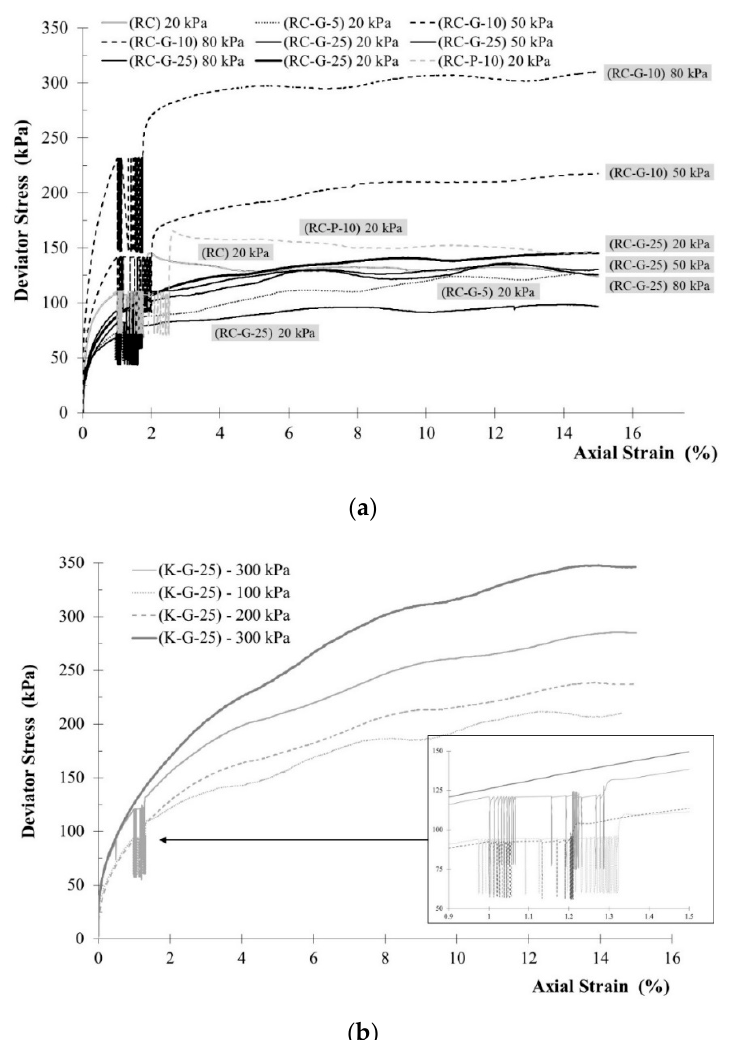
Figure 9. Deviator stress q versus axial strain ε 1 for: ( a ) (RC-R) mixtures; ( b ) (K-R) mixtures. Strengthening was observed only for monotonic tests under σ ’ 3 = 300 kPa for kaolin mixtures containing 25% granulate (K-G-25) as compared to pure kaolin ( Δ q max = +65%; Figures 9b and 10. The same mixture (K-G-25-300 kPa) weakened by 18% under cyclic loading. For red clay–rubber (RC-R) mixtures, the lack of strengthening was most likely related to specimen preparation, which was compacted in a Proctor apparatus at the op- timum moisture content. Mixtures prepared in this way may come loose after compaction relative to pure soil due to the energy-absorbing capacity of rubber [32,39,40,82]. Moreo- ver, the addition of rubber waste to the cohesive soil caused a density decrease in the mixture (Table 3). These facts help to explain the overall decrease in shear strength in the soil–rubber waste mixtures relative to the soil itself. Furthermore, Figures 9 and 10 show that maximum failure stress was achieved at different axial strains. For red clay and all mixtures, higher deformations were obtained for the maximum deviator stress with in- creasing confining pressure. This can be explained by the fact that higher confining pres- sures clearly reduced swelling. Soltani et al. [25,26] also reported a reduction in the swell- ing pressure based primarily on rubber size and shape, with coarser rubber sizes and more elongated forms being more favorable. Additionally, examples of unfavorable effects of tire-derived aggregate products with finer granulation (material marked with TDA-F [90] with a granulation similar to the powder (P) tested in this study) on soil compressive